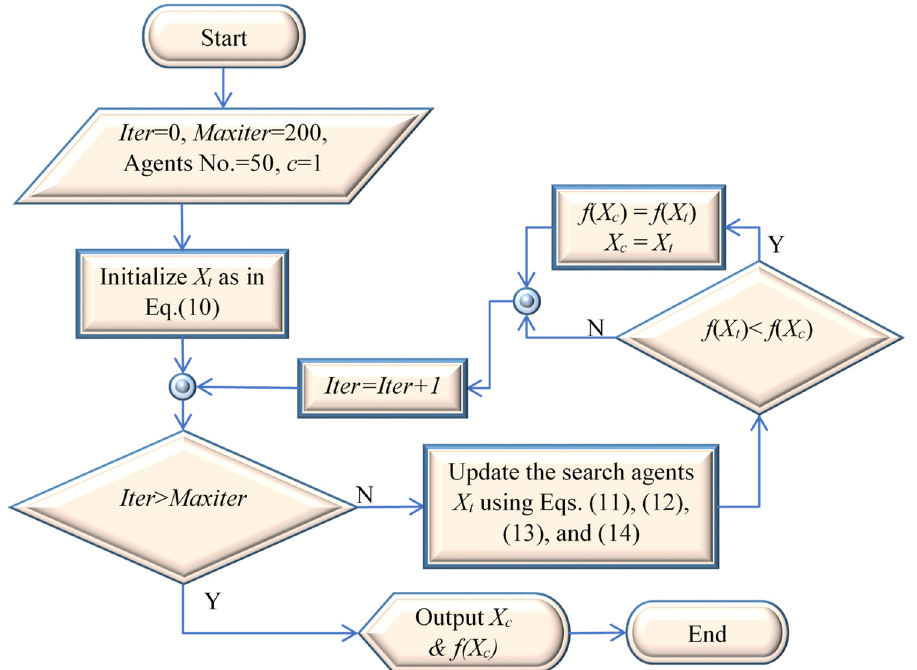
Figure 4. Flowchart of the proposed CSA.